Question: Sum up the contents of this chart in one sentence.
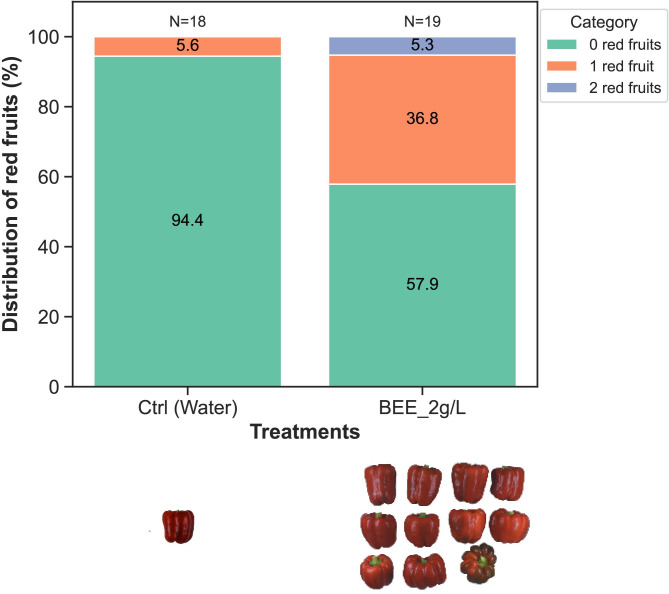
Answer: Effect of BEE treatment or control treatment on the maturity and ripeness of sweet pepper fruits under greenhouse conditions. Stacked graph of the percentage distribution of ripe (red) fruits per plant per treatment (top). Pictures comparing the ripe (red) fruits from the treated and untreated groups (bottom). BEE, Belgian endive extract; Ctrl, control treated with water.